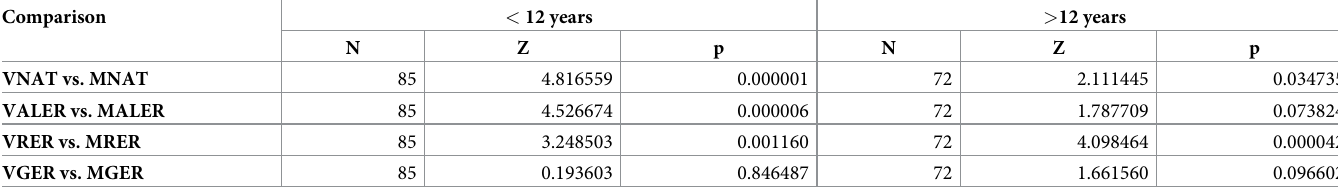
Table 4. Between-paradigm comparisons below and above 12 years of age. Results of the hypothesis tests. The conventions are the same as in Table 3. Comparison